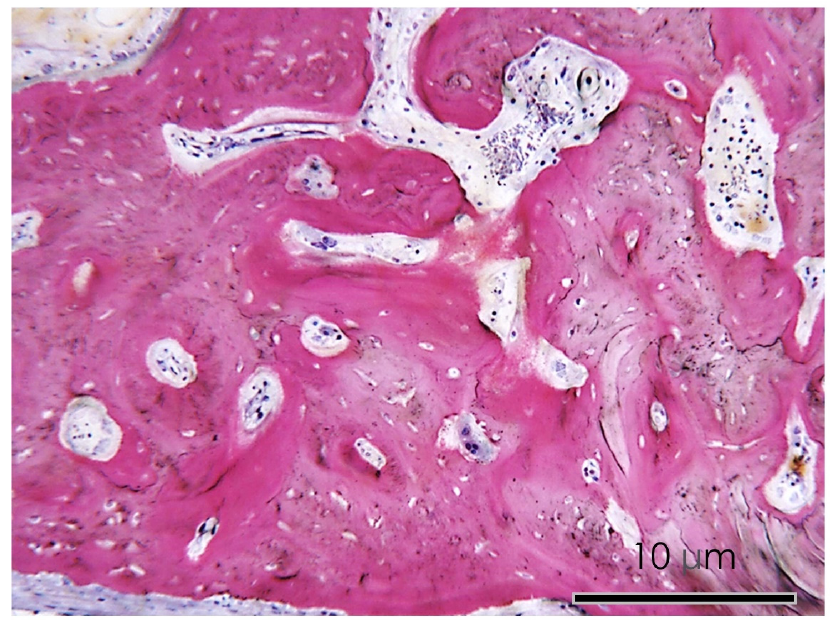
Figure 10. Resveratrol group. Detail at higher magnification of the histological section of the calvaria bone specimens (200×). A quantity of bone lacunae and osteoid matrix apposition was reported. In the curcumin group, a noncomplete filling of the bone defect was evident after 30 days of curcumin administration, and a nonorganized osteoid matrix neo-apposition was reported (Figures 11 and 12).